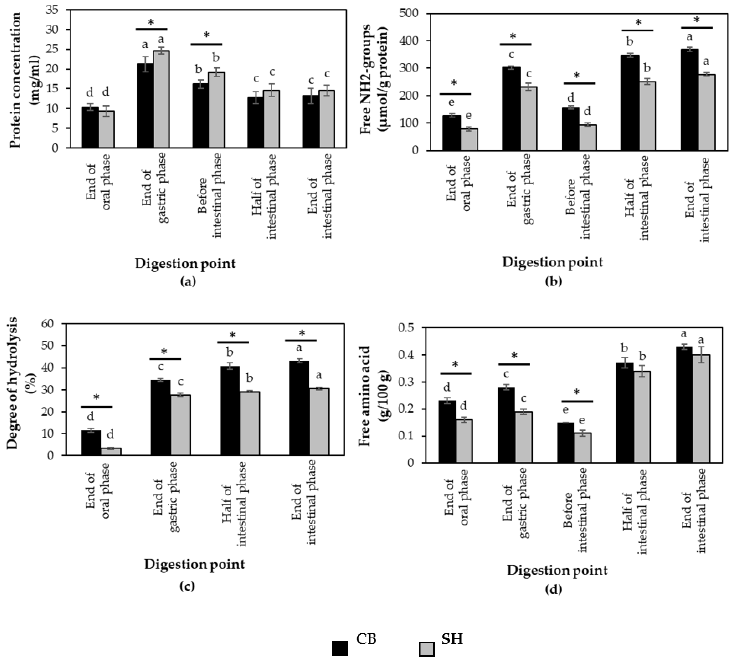
Figure 5. ( a ) Protein concentration; ( b ) free NH 2 -groups; ( c ) degree of hydrolysis (%); ( d ) free amino acid contents of commercial broiler breasts (CB) and spent commercial laying hen breasts (SH) digested by method 2 and collected at the end of oral phase, end of gastric phase and before, half and end of intestinal phase. Bars and error bars represent mean and standard deviation ( n = 4), respectively. Asterisks above bars indicate significant difference between the chicken types at particular phase ( p < 0.05). Different letters indicate significant difference among different digestion points ( p < 0.05). Table 3. Free amino acid profile from gas chromatography-mass spectrometry (GC-MS) analysis of commercial broiler breasts (CB) and spent commercial laying hen breasts (SH) digested by method 2 and collected at end of oral phase (P1) and end of intestinal phase